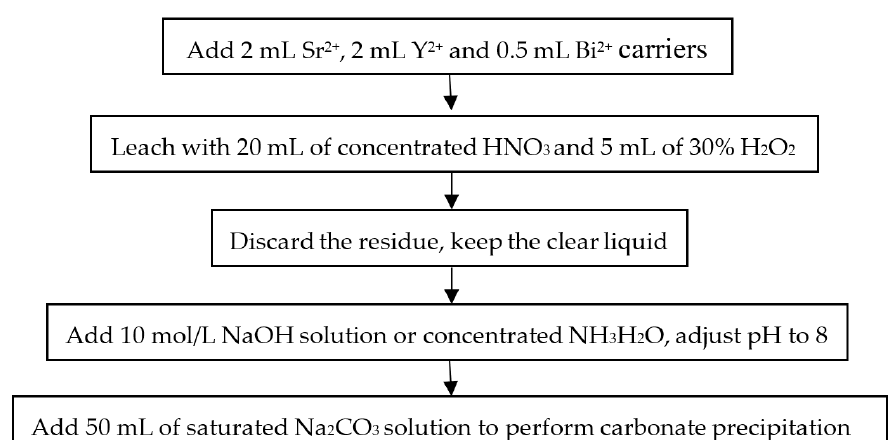
Figure 1. Pretreatment procedure for the marine biota